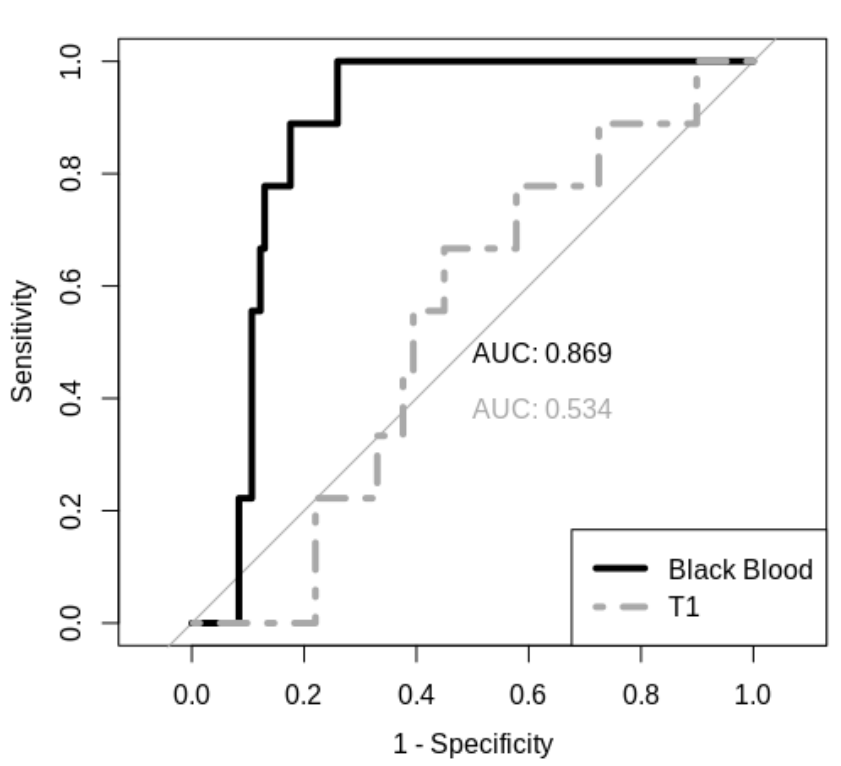
Figure 5. Sensitivity and specificity curves (BB in black, conventional T1 in grey).